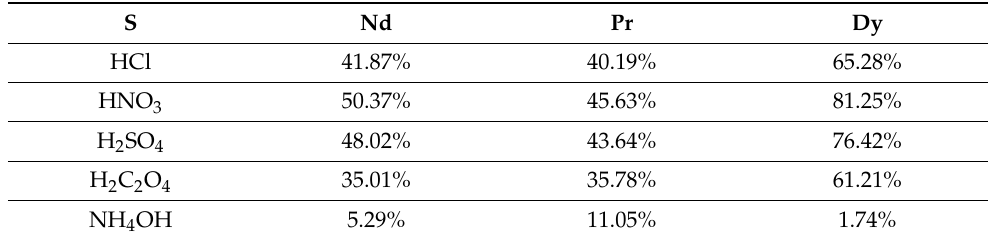
Table 4. Stripping efficiency with different chemicals. Fixed parameters: concentration of 1 M, A/O ratio of 1, contacting time of 10 min.